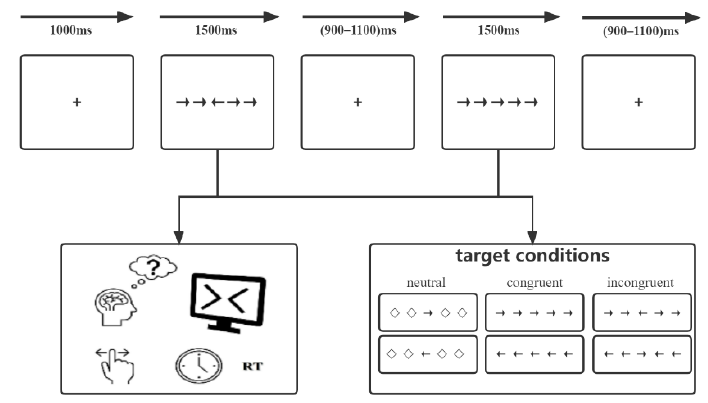
Figure 1. The modified Eriksen flanker task paradigm.